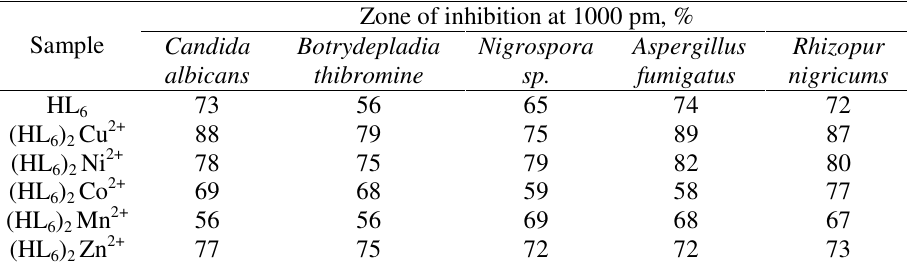
Table 2. Antifungal activity of ligand HL and its metal chelates 6 Zone of inhibition at 1000 pm,